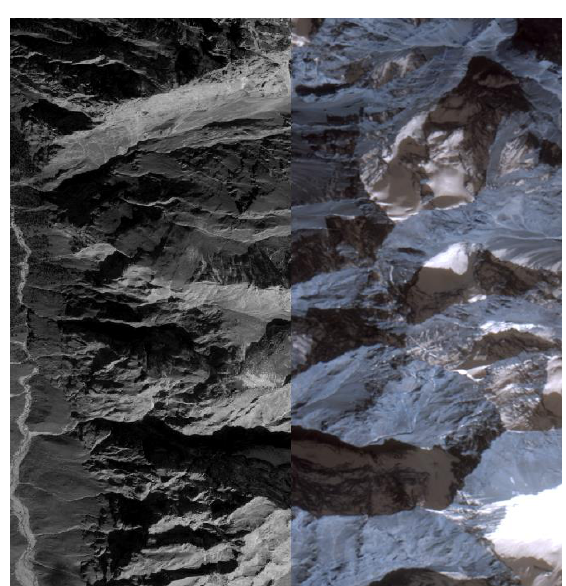
Figure 5. Full-color image and multispectral image overlay (3)